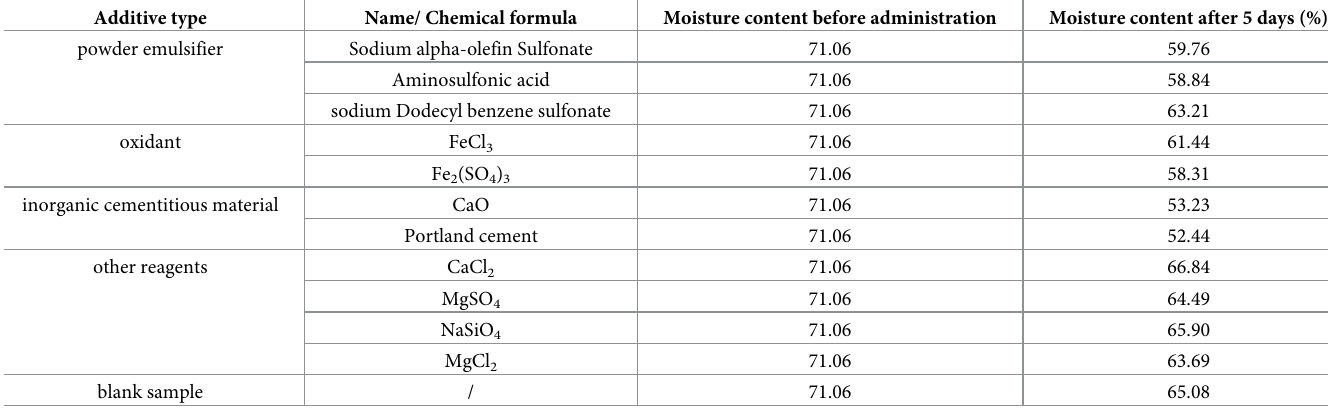
Table 1. Preliminary screening and evaluation results of modified materials. Additive